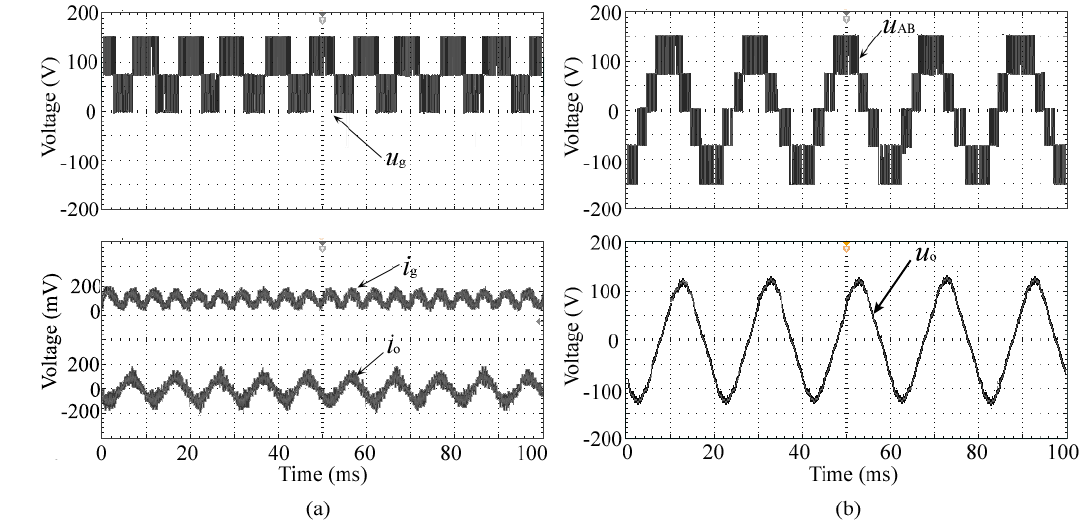
Figure 9. The experimental results of the operation of the five-level prototype using CPS EBC. ( a ) The output voltage u g of the first stage (figure top); The current i g and i o (figure bottom); and ( b ) The stepped voltage u AB (figure top); The output voltage u o (figure